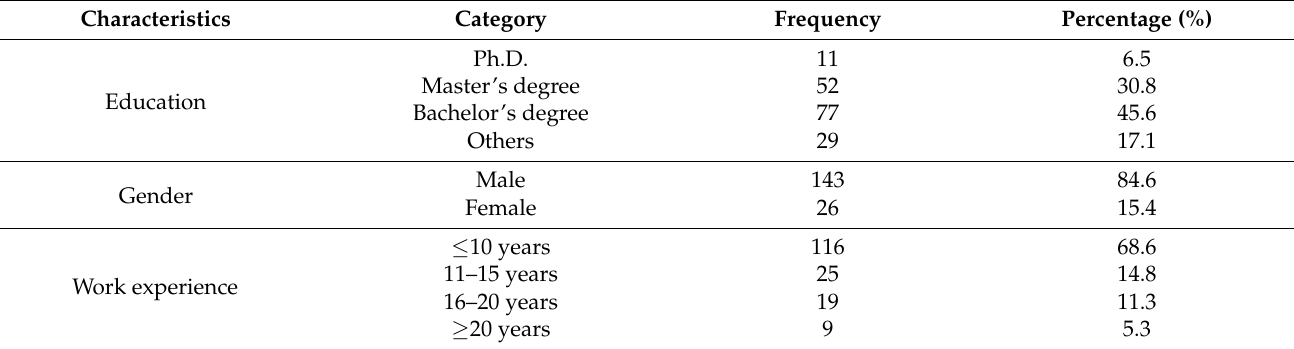
Table 2. Statistical analysis of the returned 169 valid